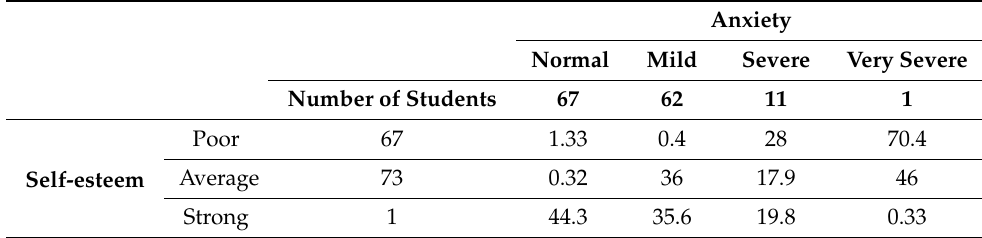
Table 5. The probability matrix between self-esteem and anxiety combinations. The values are in